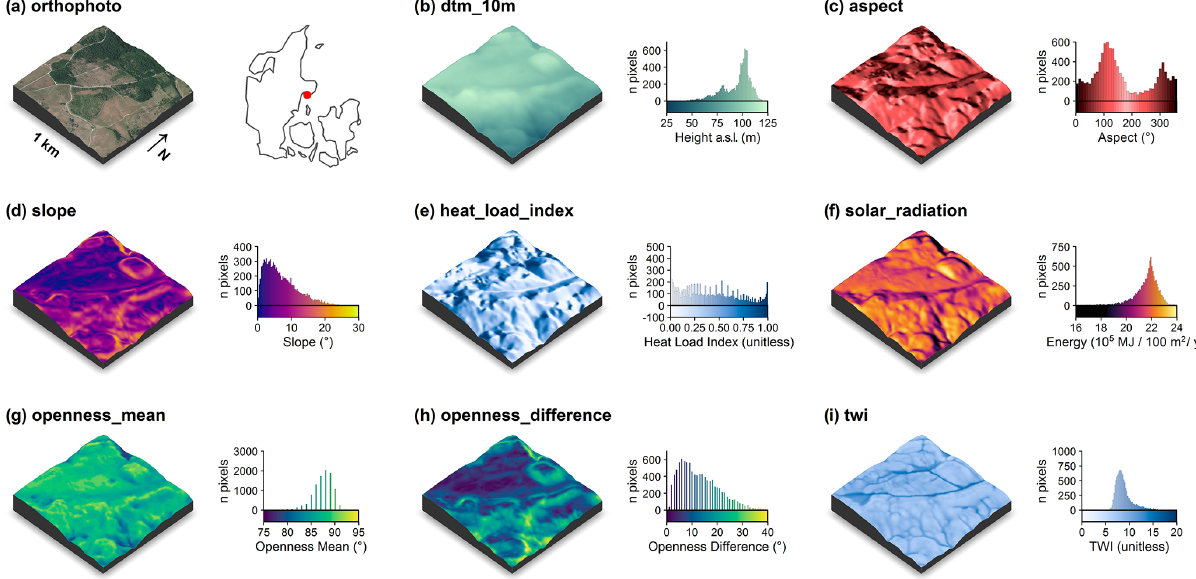
Figure 2. Illustration of the terrain-model-derived descriptors for a 1km × 1km tile in the Mols Bjerge area (tile id: 6230_595). An orthophoto and the tile location relative to Denmark are shown in (a) . The terrain model (dtm_10m) is illustrated in (b) . The terrain-derived descriptors are comprised of (c) the topographic aspect, (d) the topographic slope, (e) the heat load index following McCune and Keon (2002), (f) the estimated incident solar radiation, (g) the landscape openness mean, (h) the landscape openness difference in the eight cardinal directions and (i) the topographic wetness index (TWI) based on Kopecký et al. (2020). For visualisation purposes, we amplified the altitude above sea level by a factor of 2 in the three-dimensional visualisations and divided the solar radiation values by 10 5 . The three-dimensional raster visualisations were generated using the rayshader v0.19.2 package in R (Morgan-Wall, 2020). Orthophoto provided by the Danish Agency for Data Supply and Efficiency (https://sdfe.dk/hent-data/fotos-og-geodanmark-data/, last access: 28 June